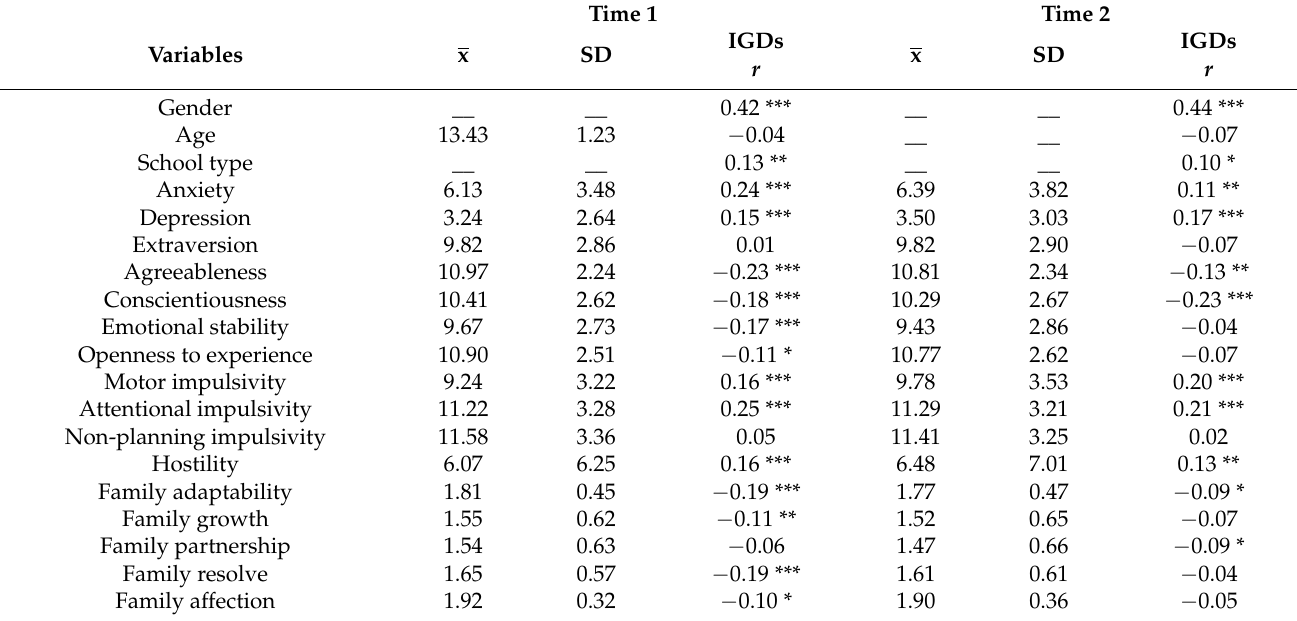
Table 1. Descriptive statistics and correlations for Time 1 and Time 2 ( n =